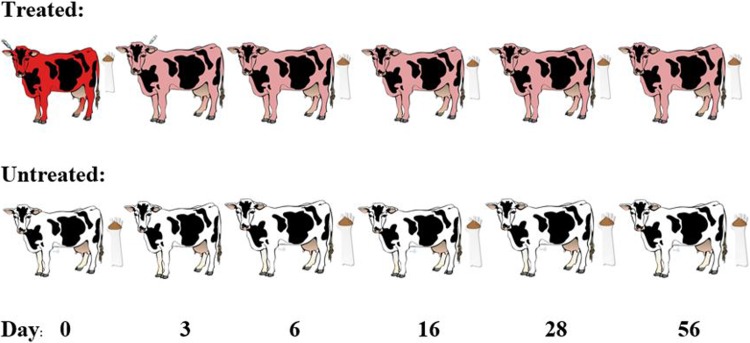
Schematic of study design.Study design is displayed above. The red cow is indicates status at metritis diagnosis, pink cows represent a cow with metritis having been treated with ceftiofur crystalline-free acid (CCFA), while white cows represent healthy pair-matched controls. The syringe by the ear of the first 2 cows in the treated group represent the administration of CCFA in contralateral ears. Gloves with feces represent days at which samples were collected. Day 0 samples were collected prior to CCFA administration.